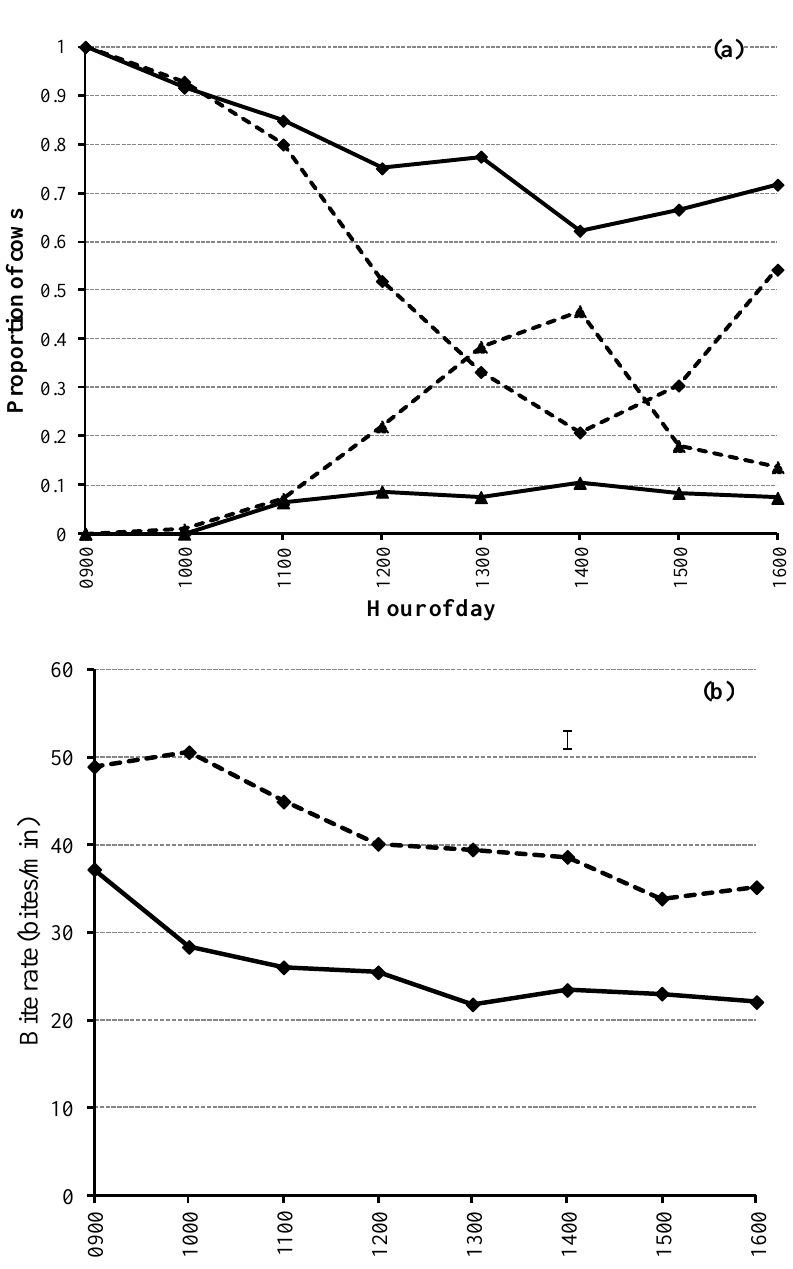
Figure 3. (a) Effect of available grazing time on the proportion of dairy cows eating (diamonds) and ruminating (triangles) for soybean (solid line) and pasture (dashed line). (b) Effect of available grazing time on bite rate (bites/minute) for dairy cows offered pasture (dashed line) or soybean (solid line). Error bar indicates the average standard error of the